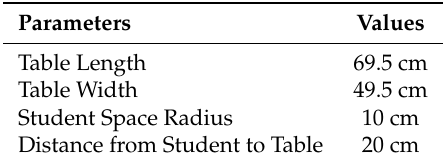
Table 1. List of parameters measured from the studied classrooms, implemented into the scenario modeling and table distribution